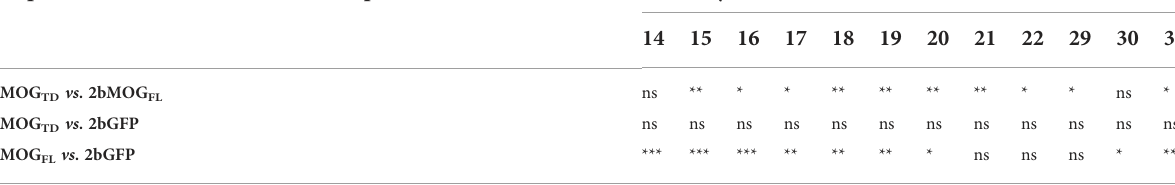
TABLE 1 Statistical analysis of the clinical score in 2bMOG TD and 2bMOG FL -transduced recipients after EAE induction Comparisons of the clinical score in recipients after EAE